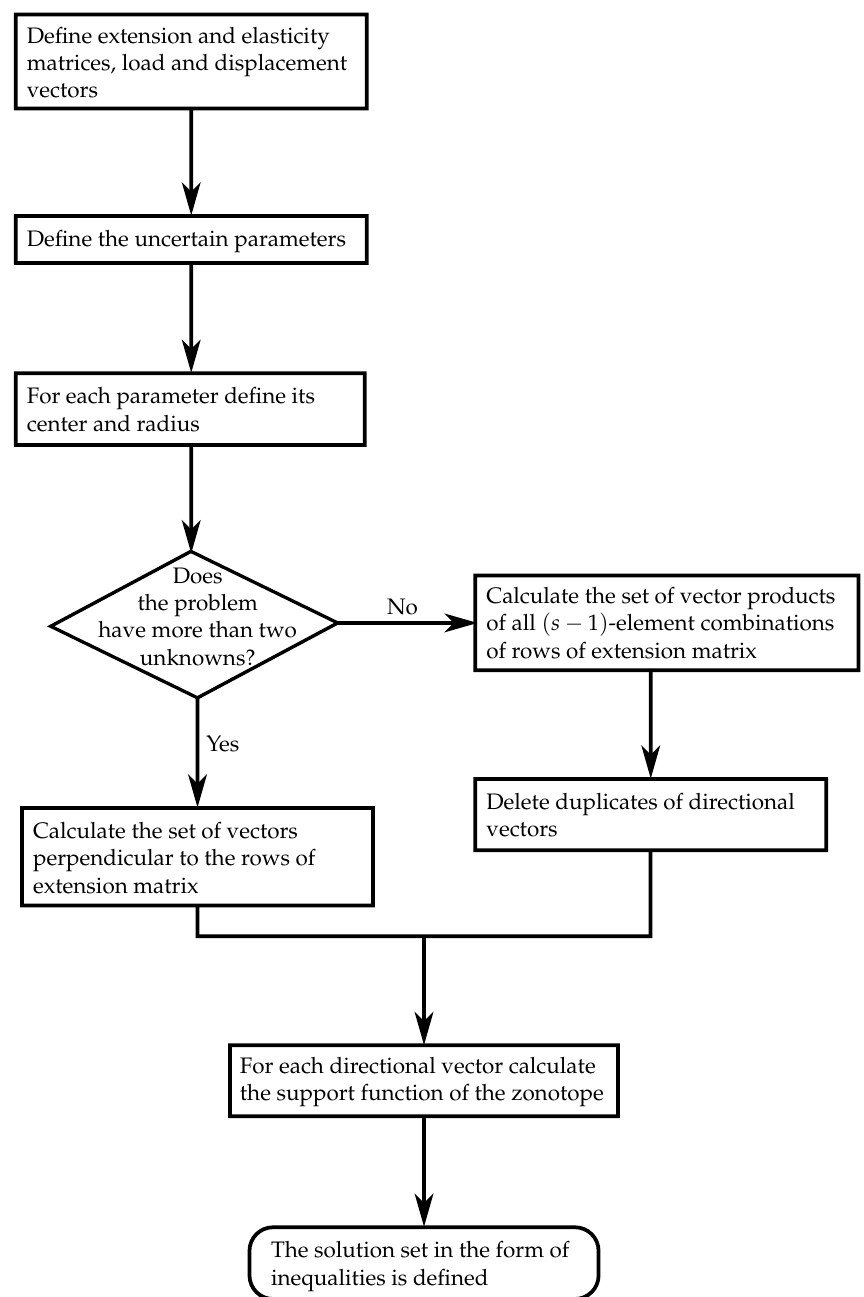
Figure 1. Diagram of searching for a solution set in the form of inequalities, assuming truss